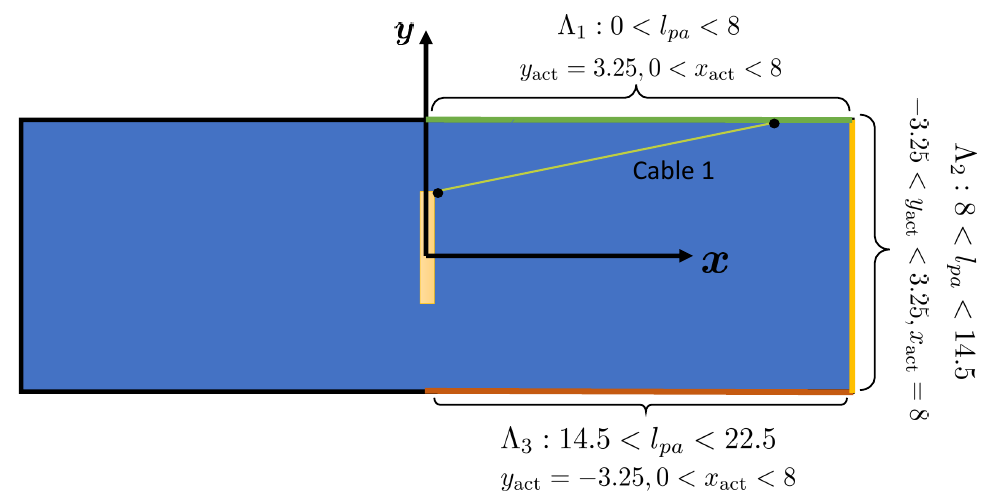
Figure 8. Moored barge in the basin, highlighting allowed placement of cable exit point for Cable